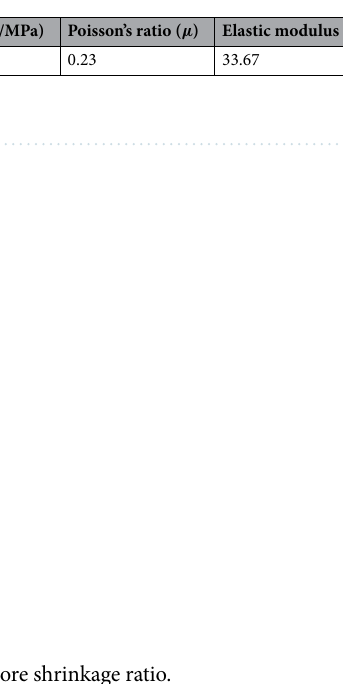
Figure 10. Comparison between creep test curve and simulated curve with an established model.